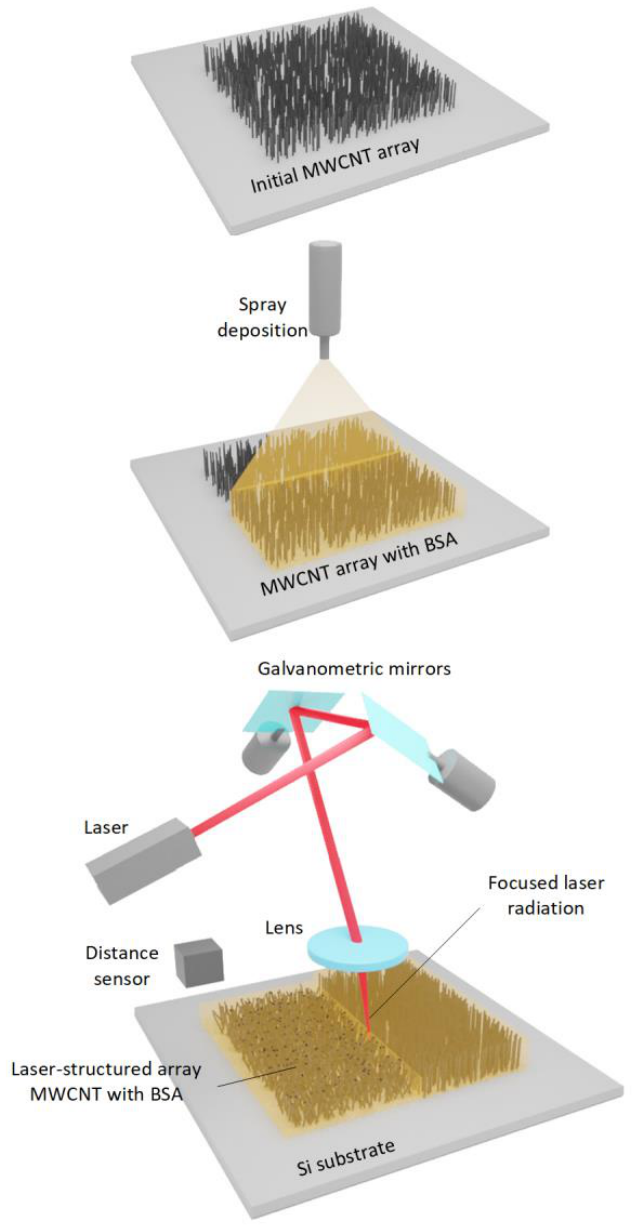
Figure 1. Manufacturing process of electrically conductive interfaces.